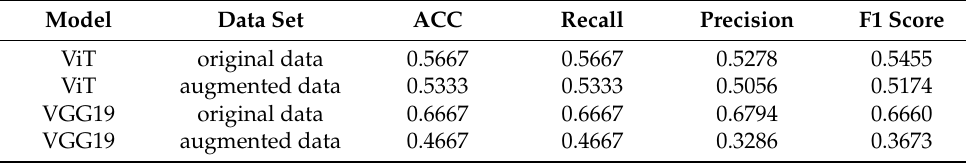
Table 6. Three-class classification performance of ViT and VGG19.